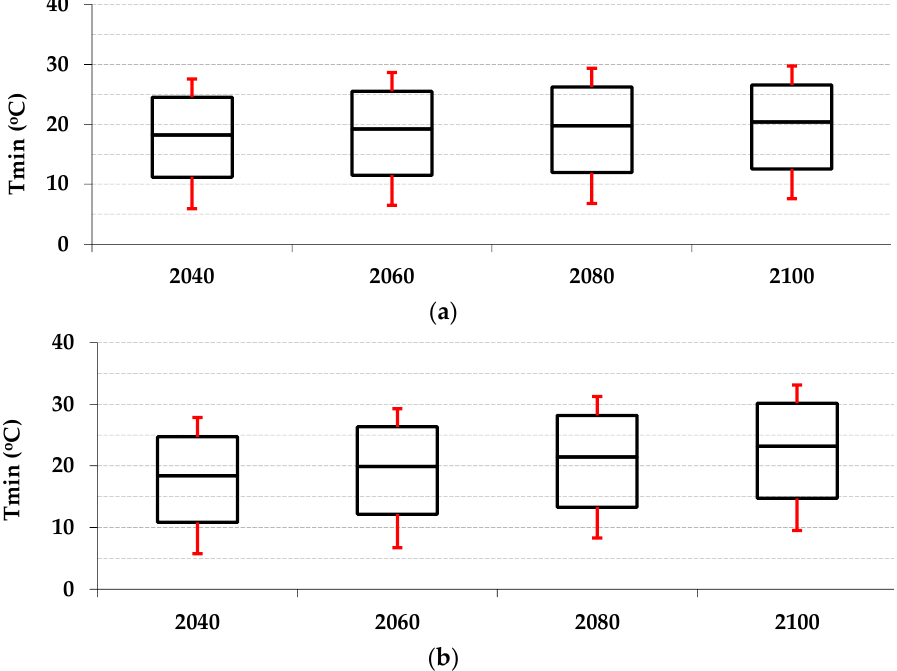
Figure 9. Box Plot of annual Tmin for four climate models under ( a ) SSP2-4.5 and ( b ) SSP5-8.5.